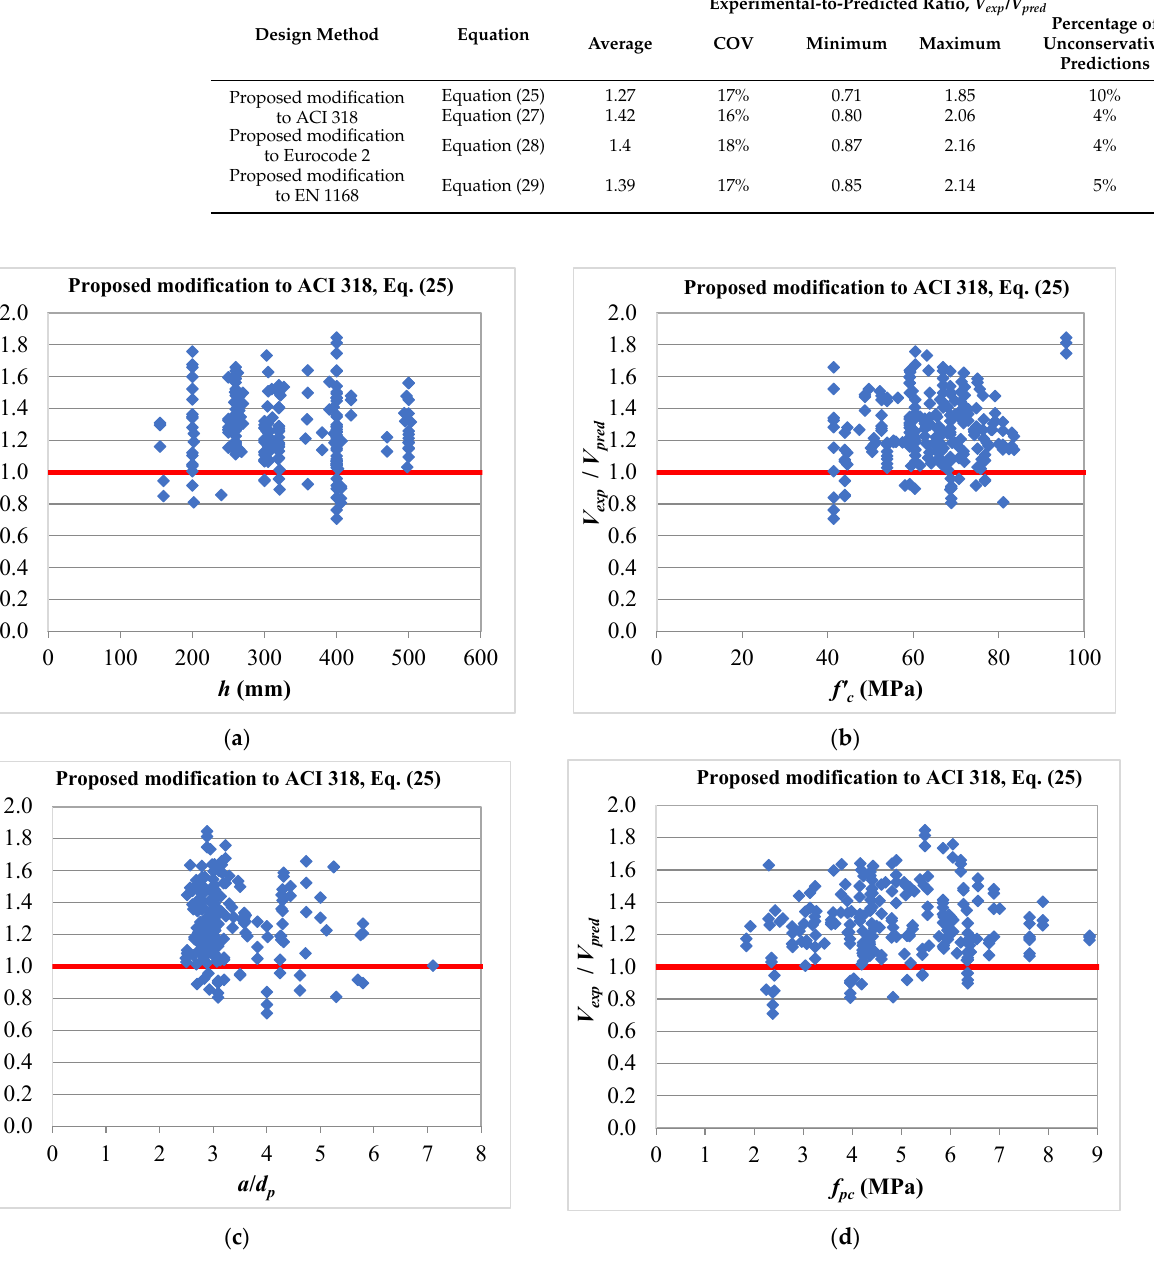
Table 3. Statistical analysis of proposed design equations.